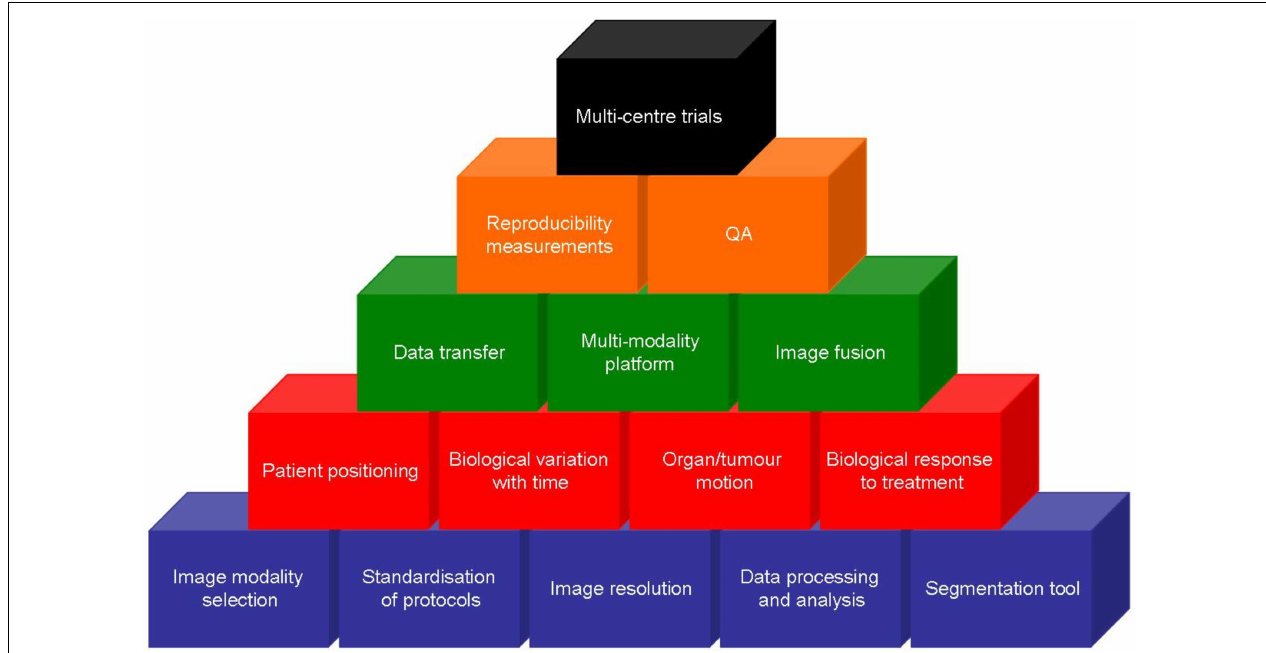
before the influence of biological factors (red) can be interpreted. Data transfer and widely available multi-modality viewing platforms (green) need to be developed with rigors QA and robust data (orange) before ultimately, multi-center trials can be